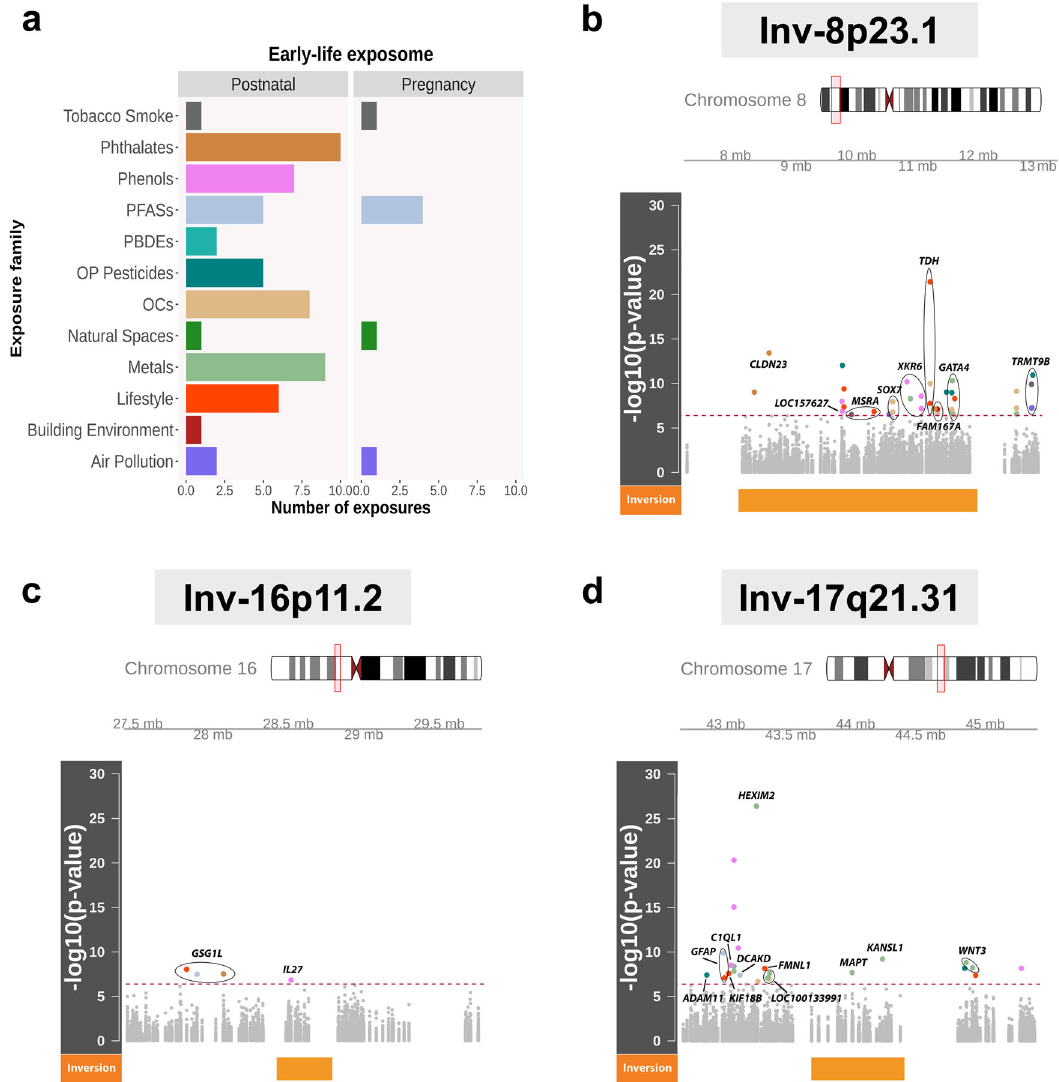
Fig. 2 Inversion-exposure interactions as methylation quantitative trait loci (mQTL) of multiple CpG sites within and surrounding three common human inversions. a Number of exposures per family in the early-life exposome from the HELIX project. b – d Manhattan plots showing the signi fi cance of the associations ( N = 1009) between the differential methylation of the CpG sites and the inversion-exposure interactions across all 64 exposures in ( a ) and the genotypes of three human inversions at 8p.23.1 ( b ); 16p11.2 ( c ); and 17q21.31 ( d ), illustrated by the orange block. The x axes show the chromosome position (±1 Mb between the inversions ’ breakpoints). The y axes show the – log 10 ( P -value) of the associations. The dashed red line indicates Bonferroni ’ s threshold of signi fi cance. Signi fi cant results are colored according to the family exposure ( a ) and labeled according to the closest gene to the CpG (Illumina annotation). Gray points are not signi fi